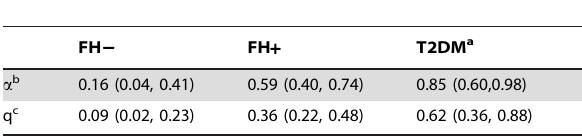
Table 3. Phenotypic proportions ( a ) and estimated risk allele frequencies (q) in FH 2 , FH + and unobserved T2DM-affected family members under a dominant model of inheritance of